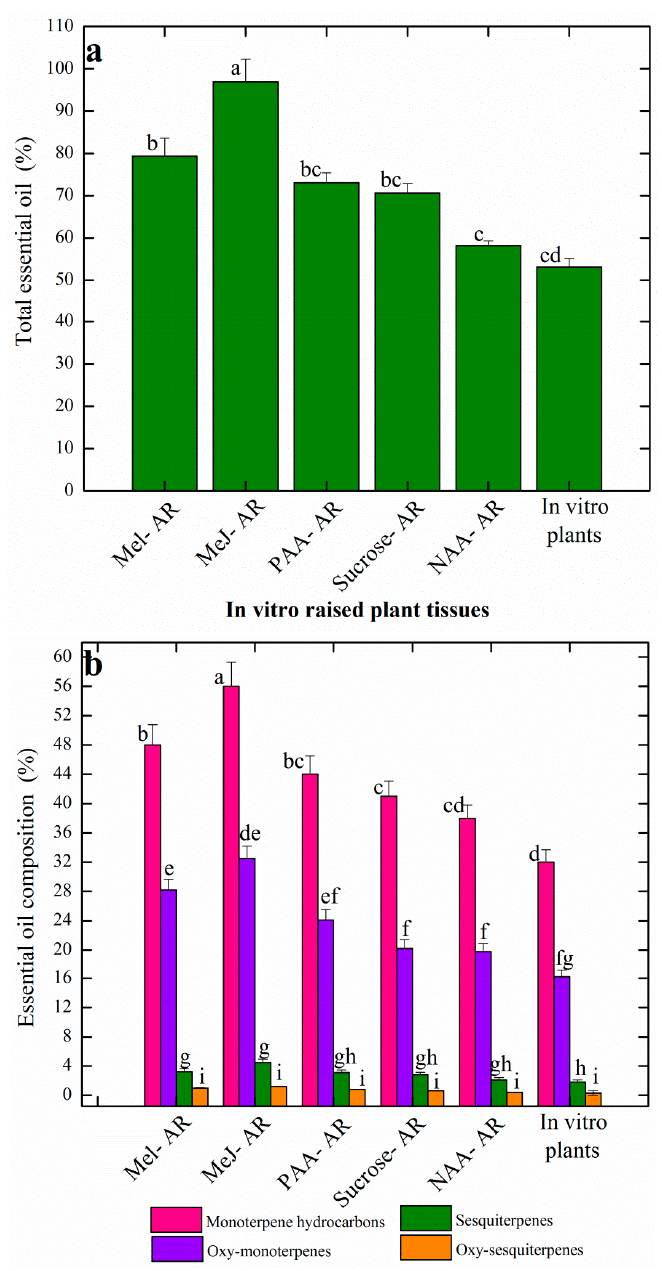
Figure 4. Evaluation of essential oil biosynthesis in the in vitro raised AR in response to di ff erent elicitor treatments and control. ( a ) Total essential oil (%); ( b) essential oil composition (%). Mel-AR: Melatonin treated AR, Me-J-AR: Methyl jasmonate treated AR, PAA-AR: Phenyl acetic acid treated AR, Sucrose-AR: AR established on solid MS media containing 1.0 mg / L NAA and 4% sucrose, NAA-AR: AR established on solid MS media containing 3% sucrose and 1.0 mg / L NAA. Data represent the mean values of triplicates with ± standard error. Annotation of columns data with di ff erent alphabet (s) represents the significance at ( P =